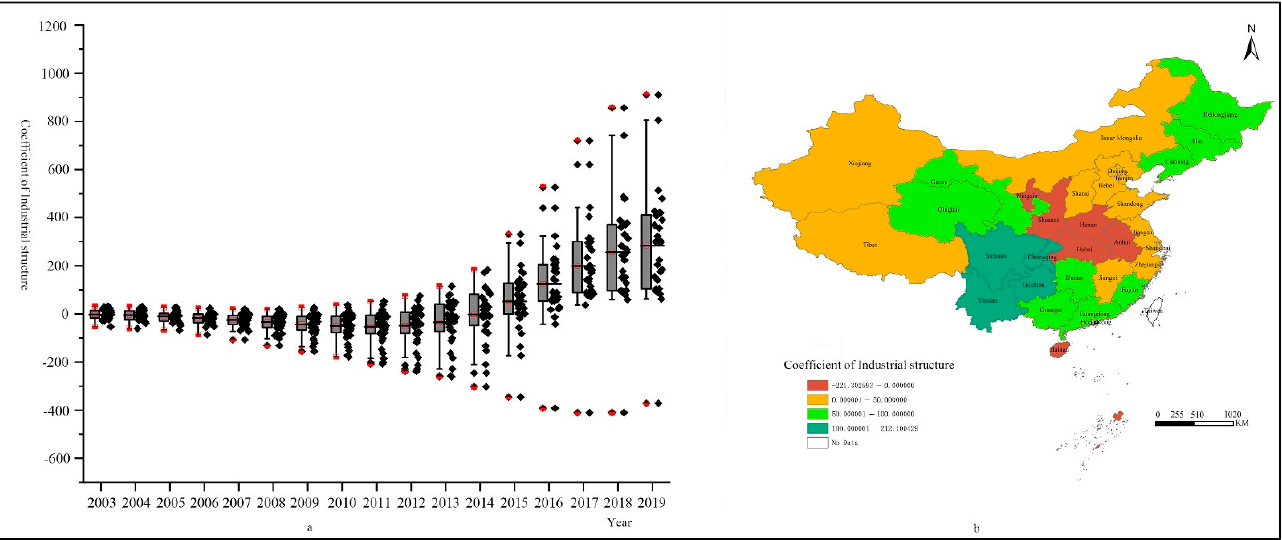
Figure 13. ( a ) Box-plot of regression coefficients of the industrial structure; ( b ) Distribution of mean value of regression coefficients of the industrial structure.